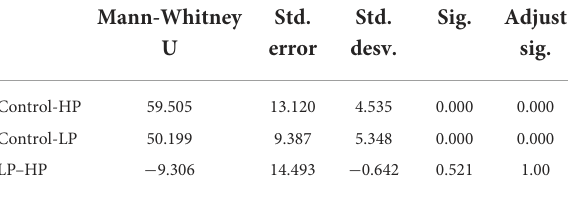
TABLE 5 Result of post-hoc by couples testing in the estimation